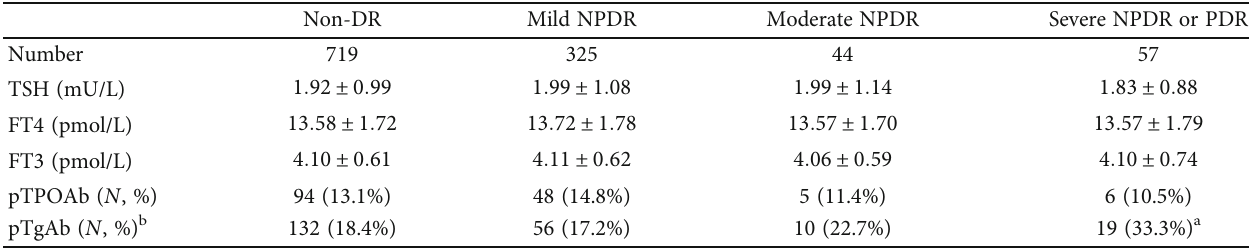
Table 2: Thyroid indicators corresponding to di ff erent severities of